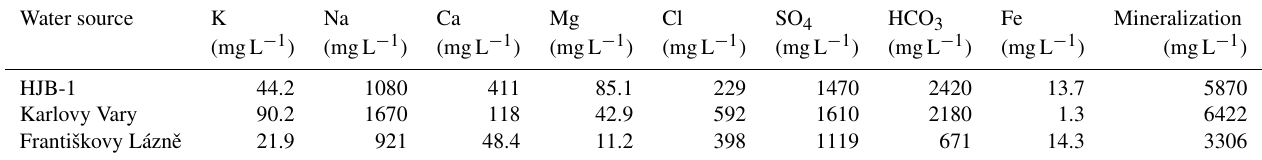
Table 1. Comparison of the chemical parameters of the recovered mineral water in HJB-1. The sampling date was 10 May 2016 (20:00 LT, end of recovery test). A comparison to the chemistry of two typical mineral waters from western Bohemia is shown (Karlovy Vary: spring Vˇrídlo (Sprudel), borehole BJ-35, 55.2m deep and Františkovy Láznˇe: spring Adler, borehole 33m deep). Water source K Na Ca Mg Cl SO 4 HCO 3 Fe Mineralization (mgL − 1 ) (mgL − 1 ) (mgL − 1 ) (mgL − 1 ) (mgL − 1 ) (mgL − 1 ) (mgL − 1 ) (mgL − 1 ) (mgL − 1 ) HJB-1 44.2 1080 411 85.1 229 1470 5870 Karlovy Vary 90.2